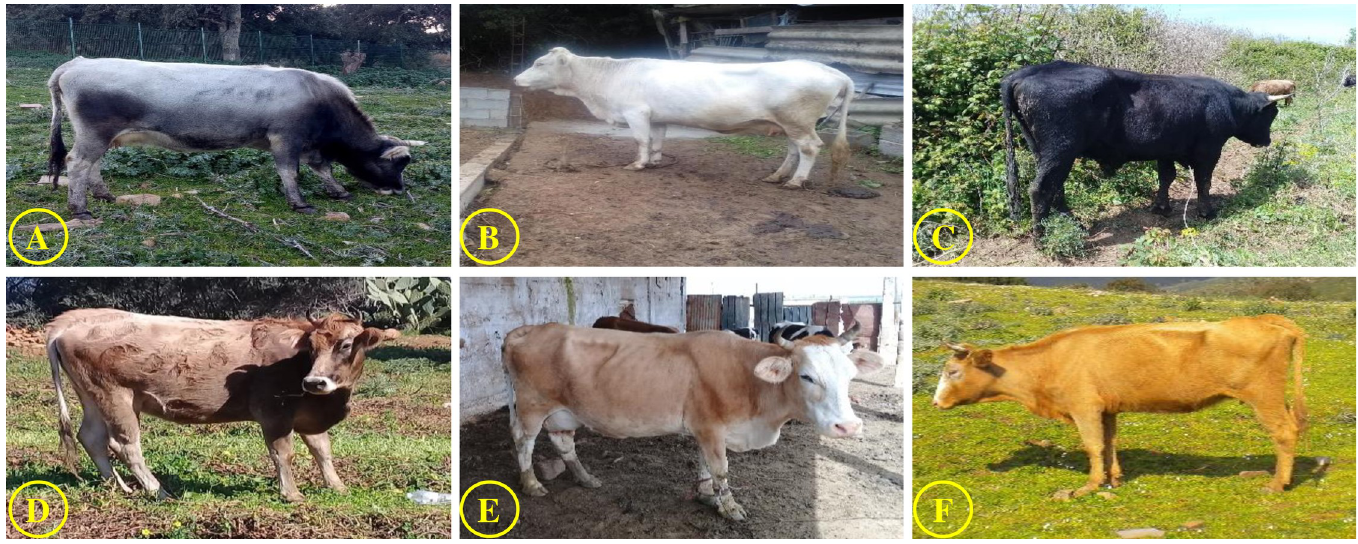
Fig 2. The four brown Atlas cattle ecotypes examined in the present study. (A) ecotype Guelmois; (B) ecotype Cheurfa (C); ecotype Se´tifien; (D), (E) and (F) ecotype Fawn.